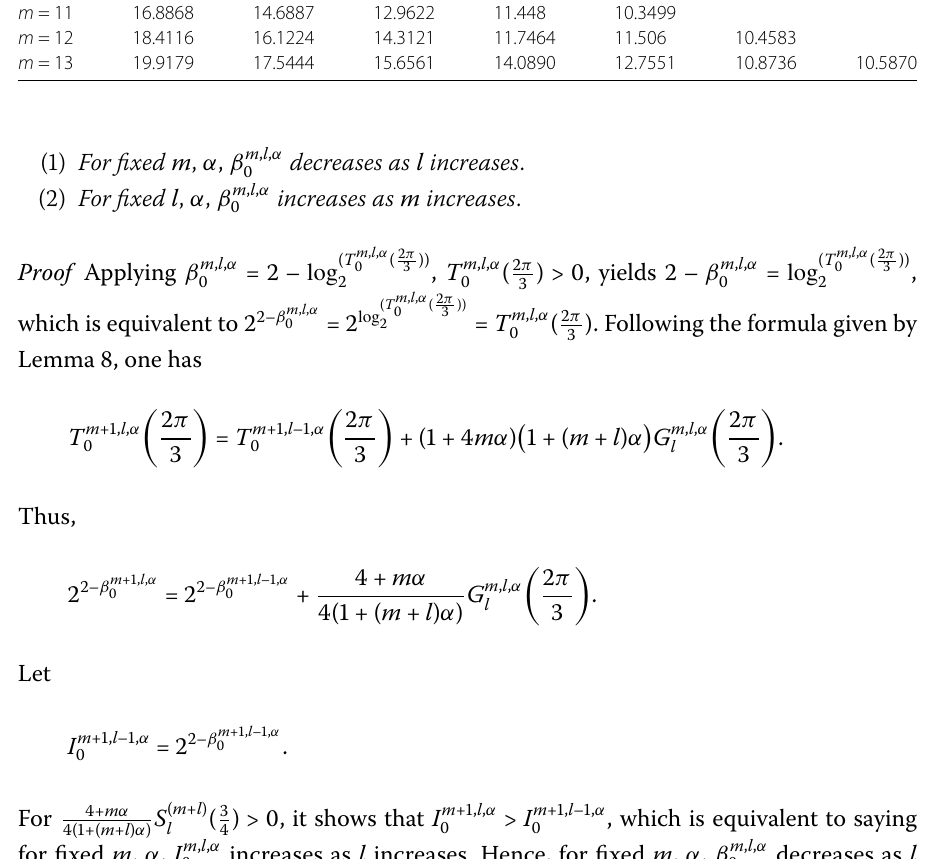
of refinable functions with the mask τ m , l , α 0